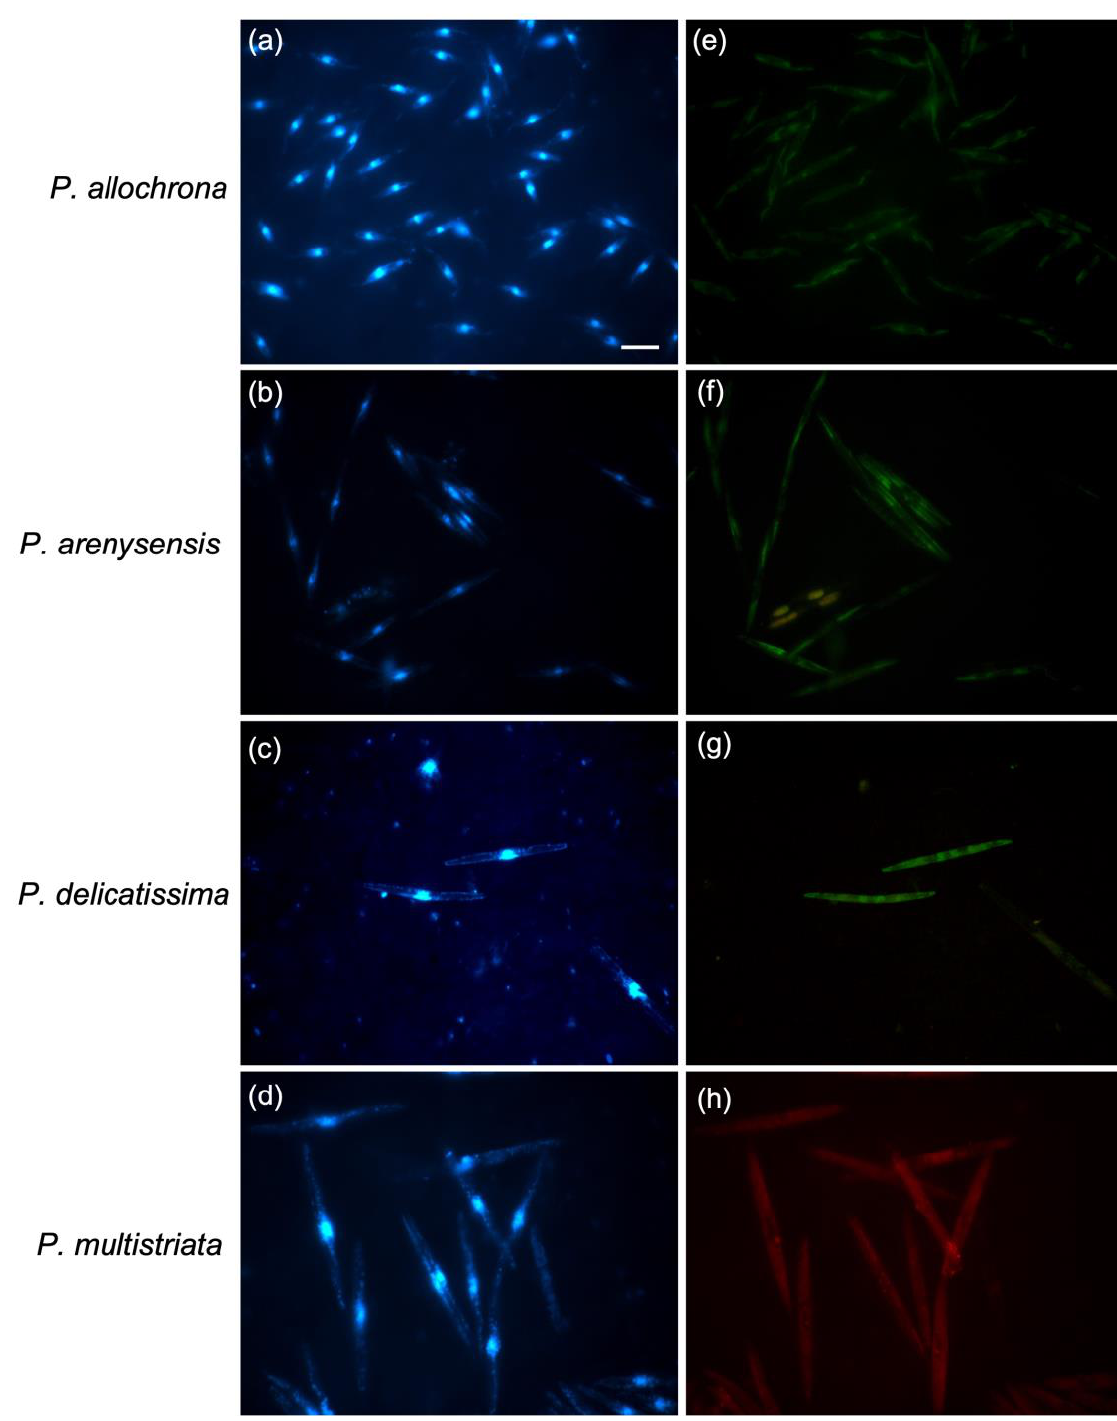
Figure 2. WC-FISH assays the pure culture of some Pseudo-nitzschia cryptic species ( a – c , e – g ) and P. multistriata hybridised to their species-specific probes. Each row of micrographs displays cells of pure cultures under fluorescence microscopy in DAPI ( a – d ) and FITC ( e – h ) filters. Scale = 10 μm.